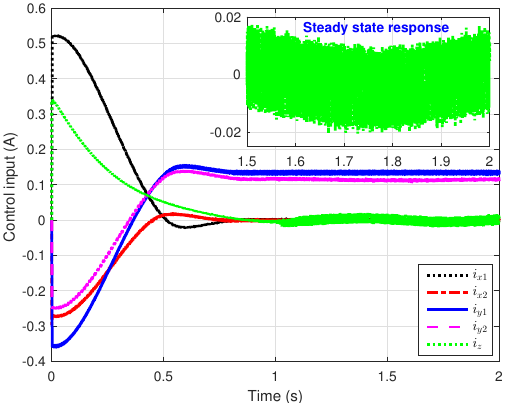
Figure 6. Time response of control inputs using AISOSMC.